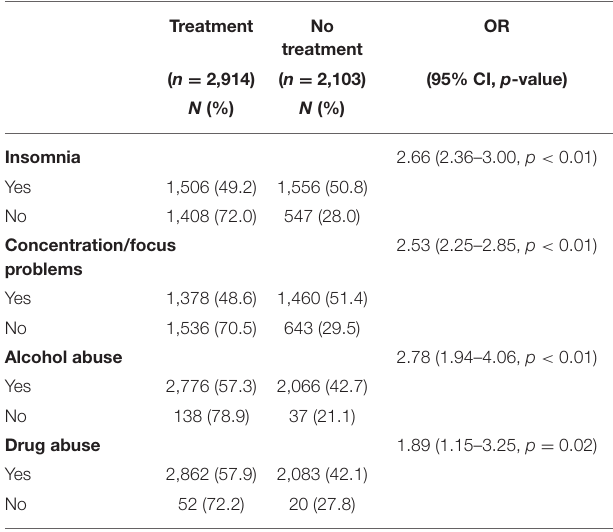
TABLE 3 | Outcomes of univariate regression analysis of tinnitus impact and characteristics and psychological/ physical effects of tinnitus between those with and without having treatment (survey “Treatment for